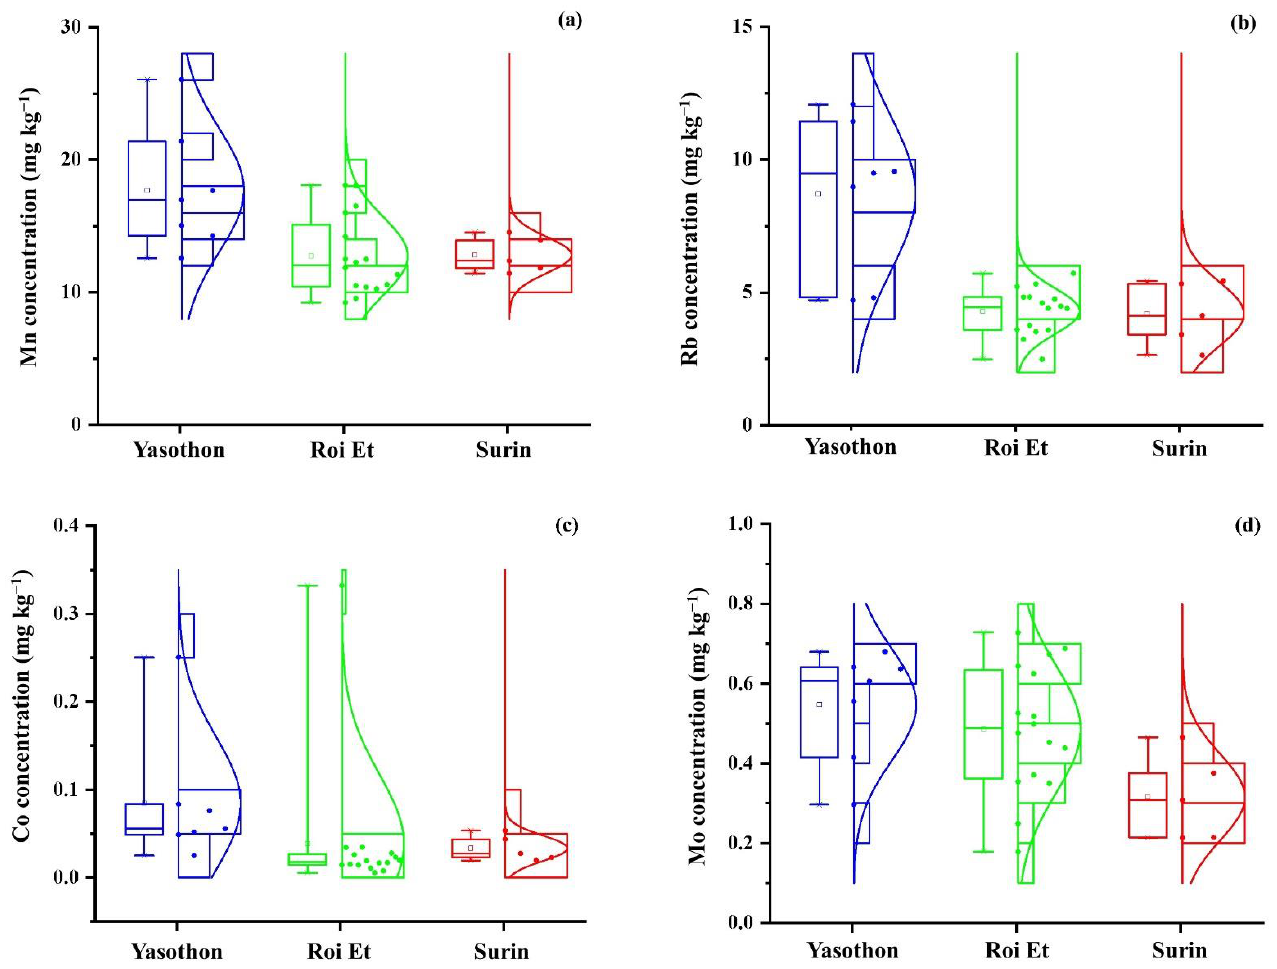
Figure 3. Box-and-whisker plots showing the variation of ( a ) Mn, ( b ) Rb, ( c ) Co, and ( d ) Mo concentrations in THMR collected in three contiguous provinces in Thailand covering YP (n = 7), RP (n = 16), and SP (n = 5), respectively.